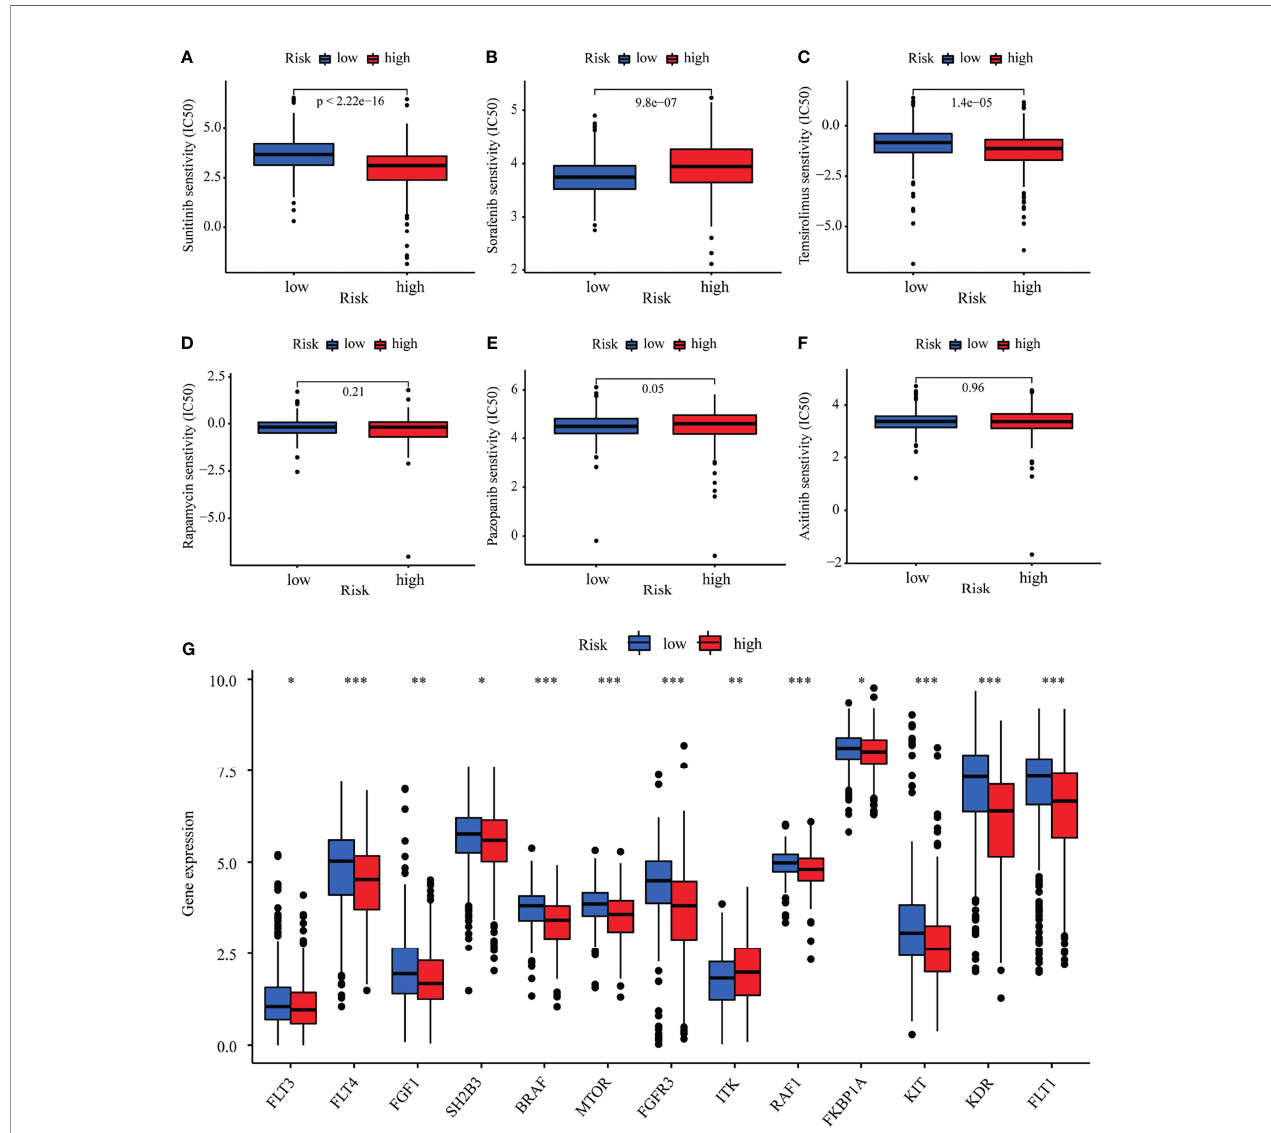
FIGURE 9 | Evaluation of therapeutic response by the lactate-related prognostic signature (LRPS). (A – F) Sensitivity analysis for sunitinib (A) , sorafenib (B) , temsirolimus (C) , rapamycin (D) , pazopanib (E) , and axitinib (F) in patients at low and high risk. (G) Differences in the expressions of the target genes after targeted drug therapy between the low- and high-risk groups. * p < 0.05, ** p < 0.01, *** p <